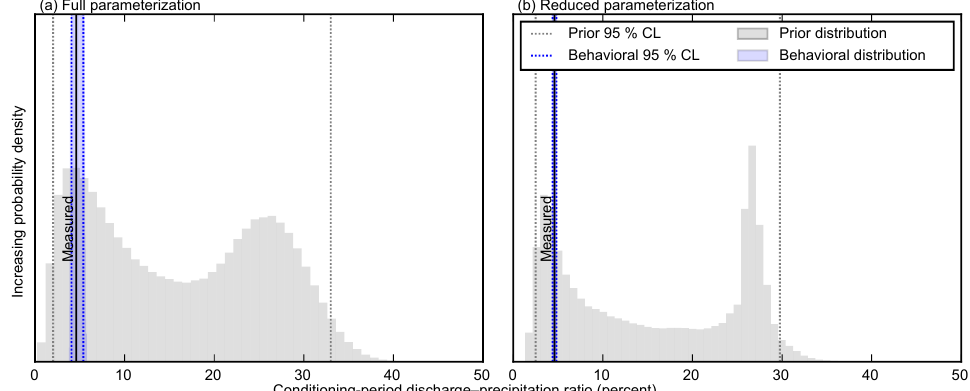
Figure 5. Quantity of interest QOI-2: simulated conditioning-period (pretreatment) streamflow as a percentage of precipitation. The effects of the conditioning process can be seen as large reduction in the range of the behavioral distribution compared to the prior distribution. The prior and behavioral distributions for model parameterizations bracket the measured